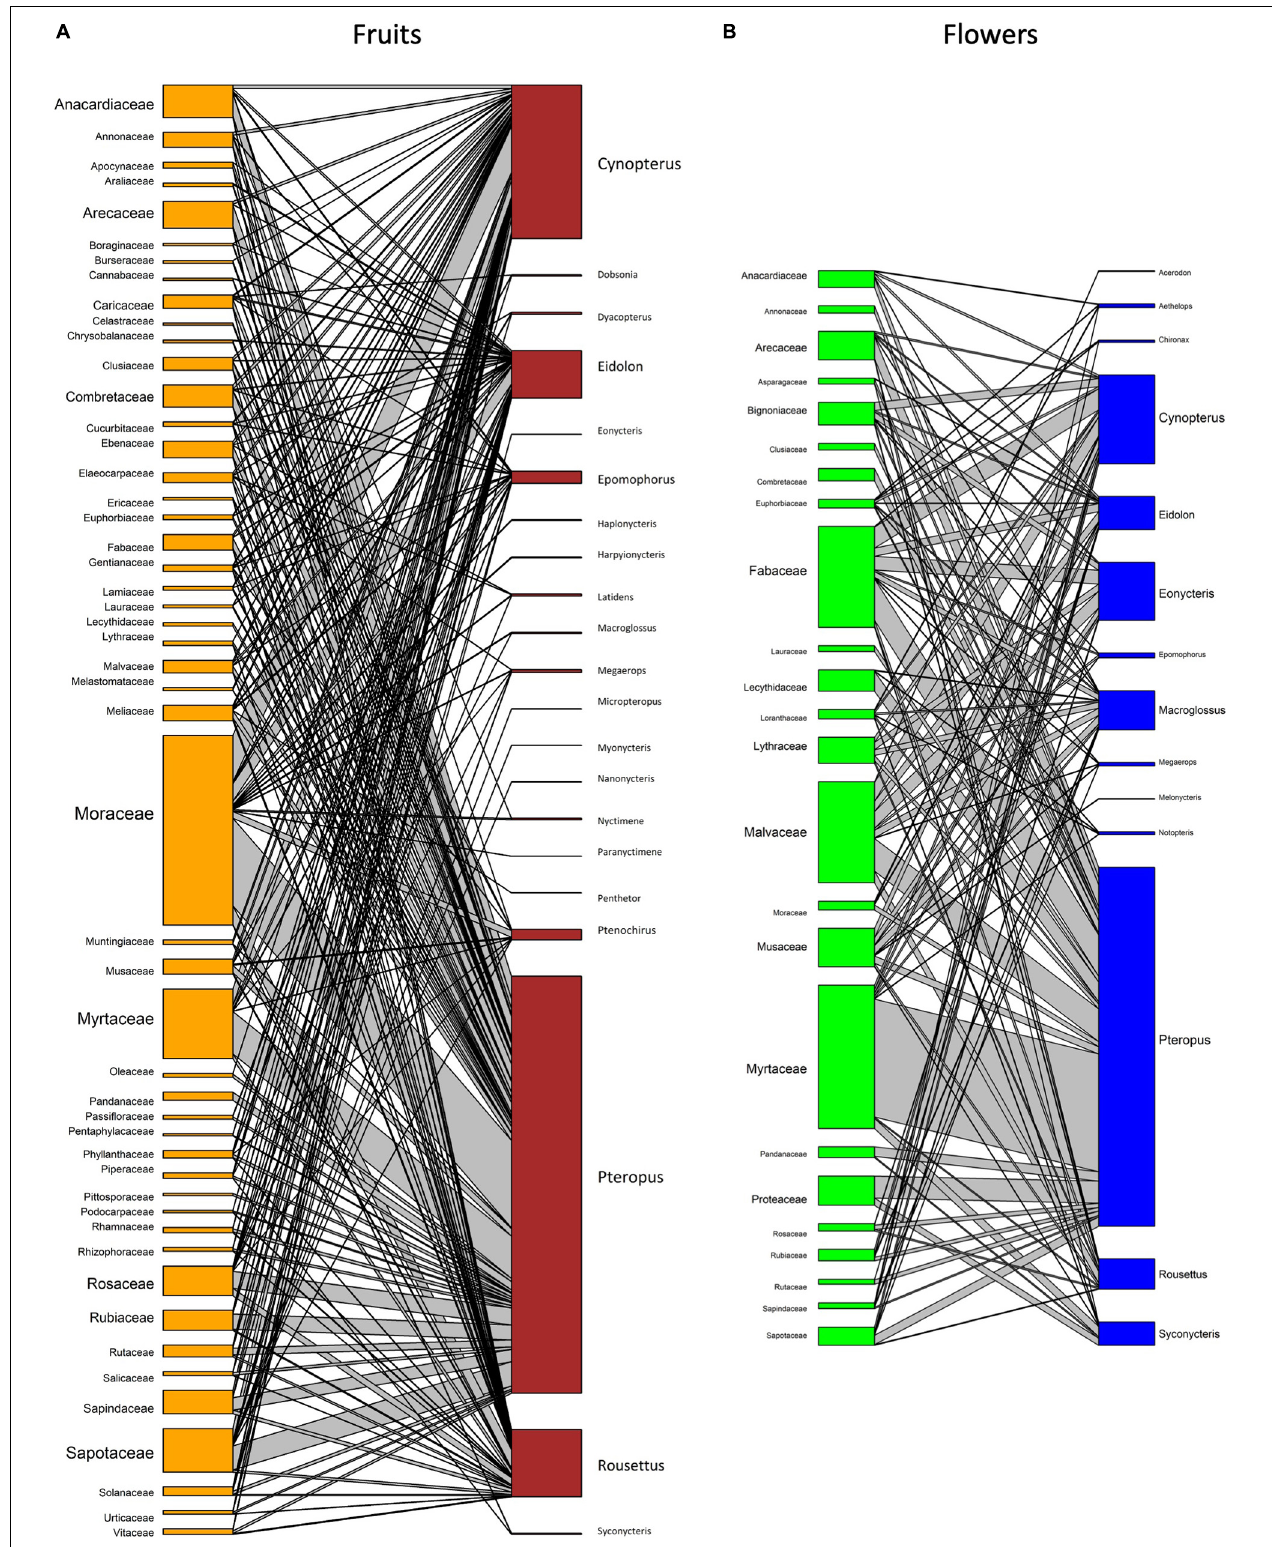
FIGURE 3 | Network graphs showing interactions between pteropodid bats (right) and the plant taxa (left; (A) flowers and (B) fruit) they interact with. Graphs are based on the number of species within each family consumed by pteropodid genera for five or more interactions recorded.